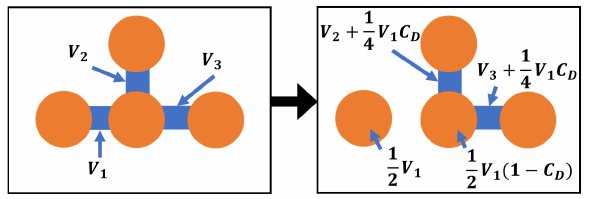
Figure 1. Schematic explanation of the liquid bridge rupture and liquid migration between particles. Adapted from Refs. [6, 8].